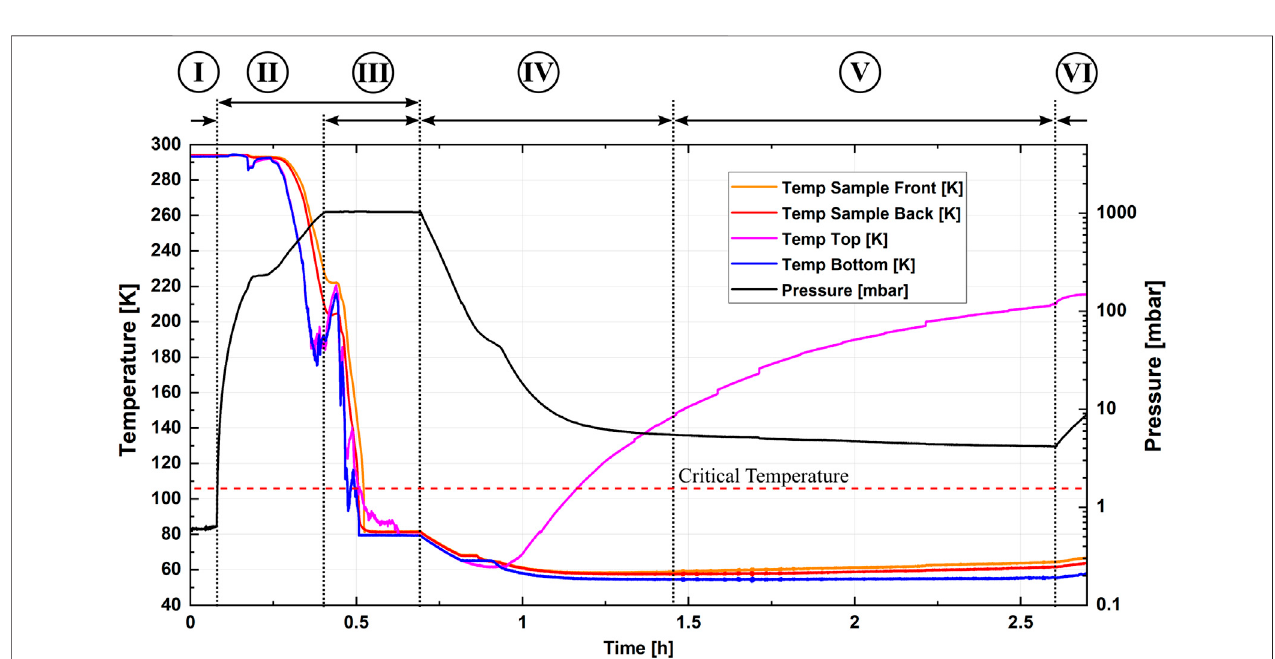
FIGURE 5 | Cryo-Box. Left: Field of view of the thermal camera focused to the XPS-Box and the surrounding structural components of the thrust balance. Right: Thermal camera image after thecooling process in vacuum tocon fi rm thermal isolation from thebalance. (A) inlet for coaxialwire and thermocouples; (B) liquid nitrogen feedthrough tube; (C) liquid nitrogen